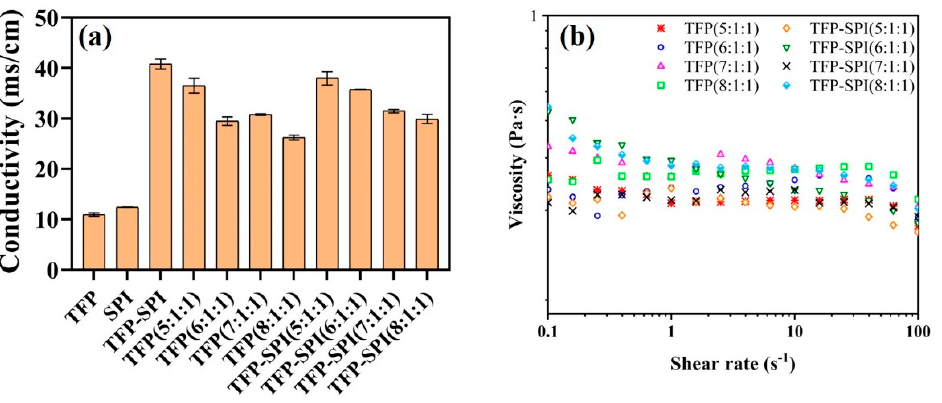
Figure 9. Electrical conductivity ( a ) and viscosity ( b ) of the electrospinning solution.